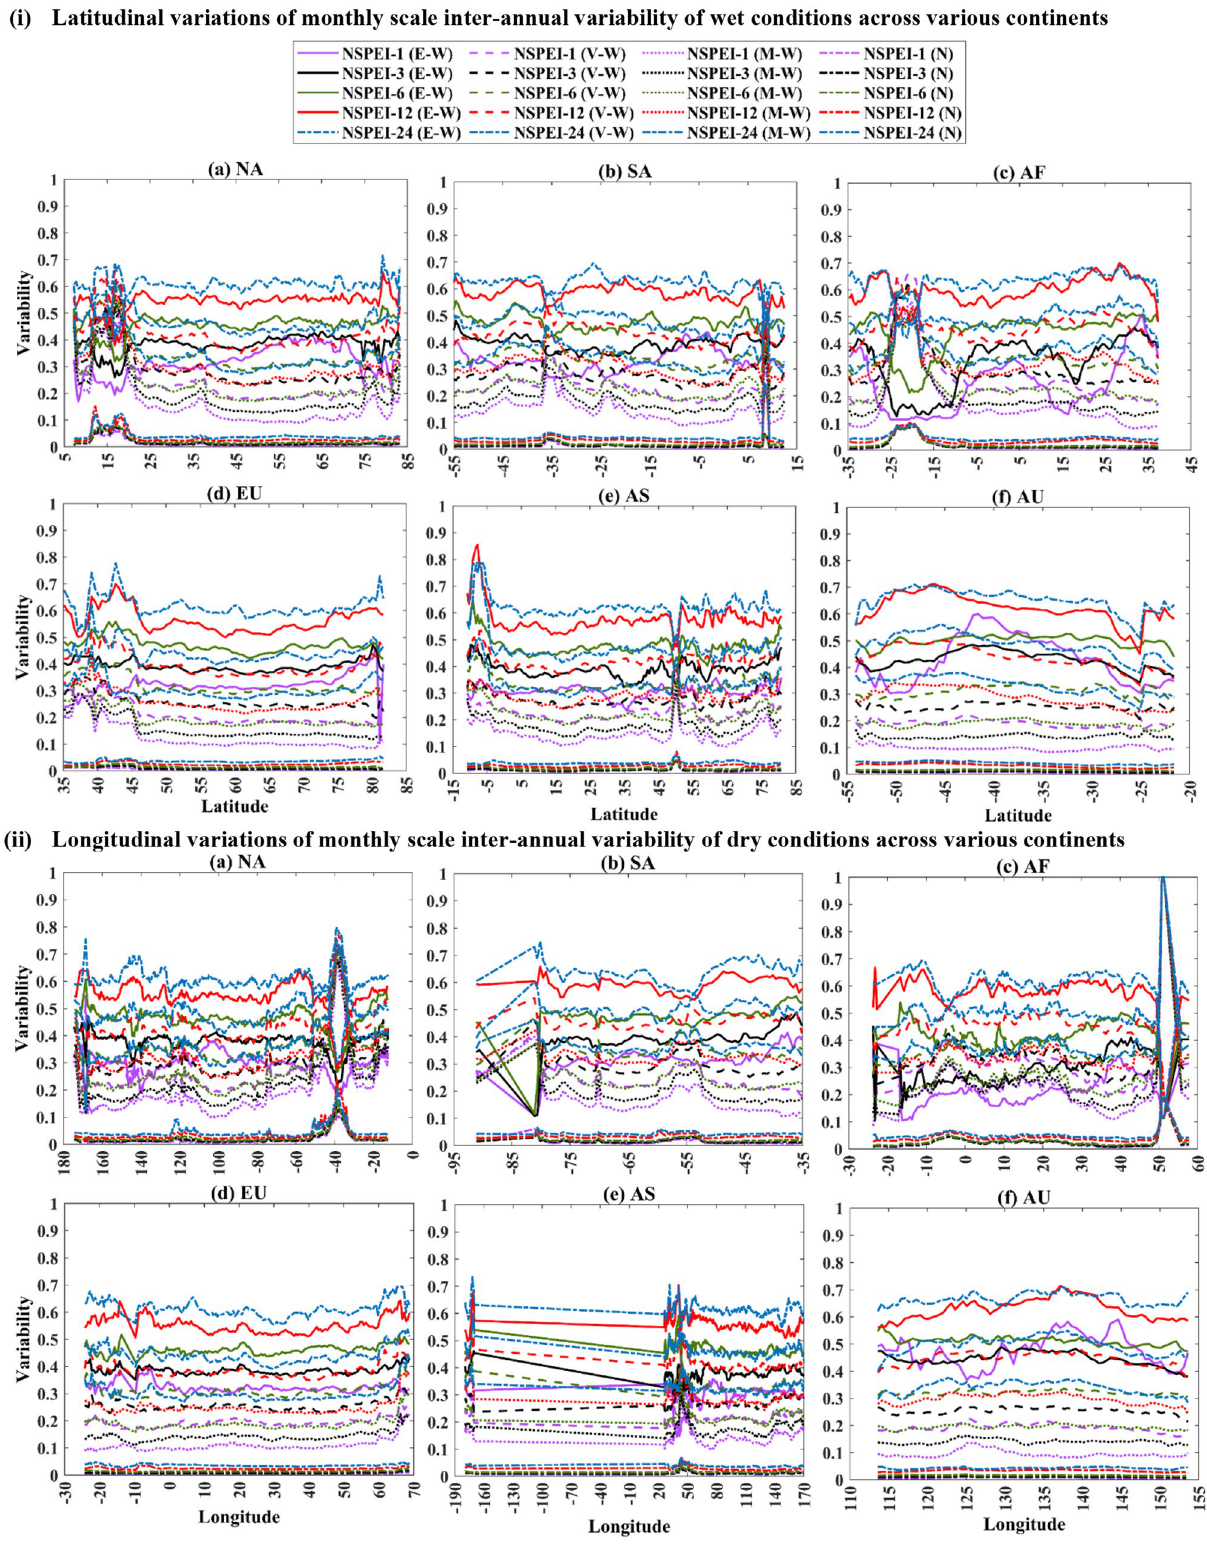
Figure 6. (i) Latitudinal and (ii) Longitudinal variation of monthly scale inter-annual variability (SVI ME ) of wet conditions across North America (NA), South America (SA), Europe (EU), Africa (AF), Asia (AS) and Australia (AU). *The plots were generated using MATLAB (version: